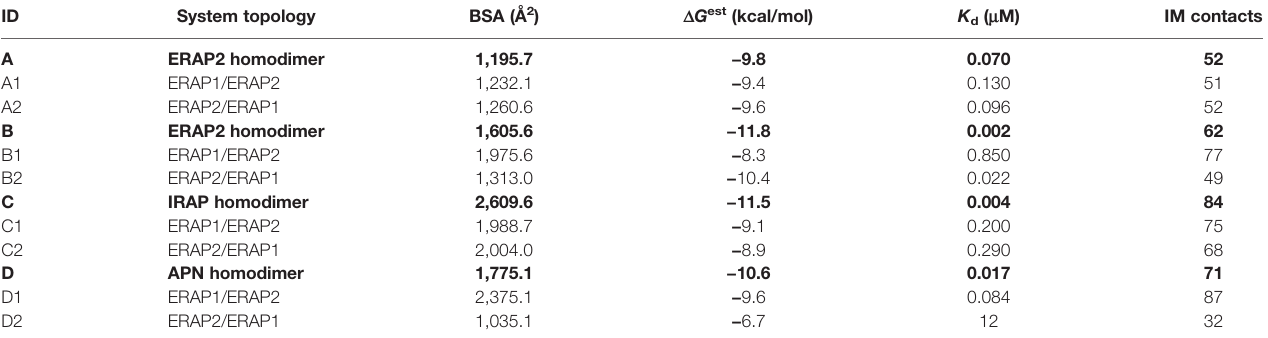
TABLE 1 | Summary of the systems employed in the MD calculations based on the 4 crystallographic homodimers A – D. ID System